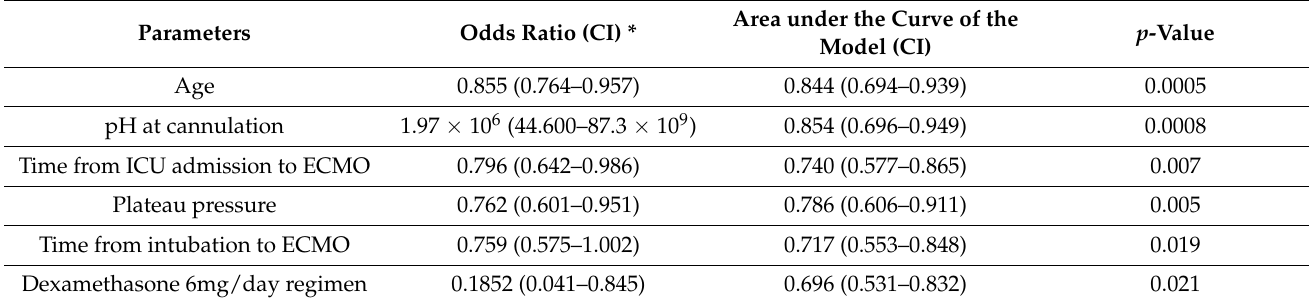
Table 5. Parameters associated with survival in univariate